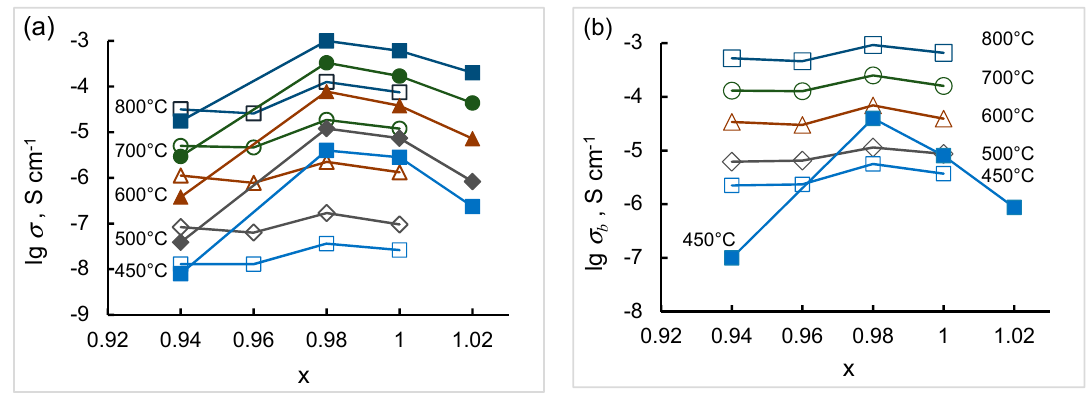
Figure 7. Total ( a ) and bulk ( b ) conductivity of SZx (empty markers) and SZYx (solid markers) as a function of strontium content in air (pH 2 O = 40 Pa). The lines between points are only a guide to the eye.